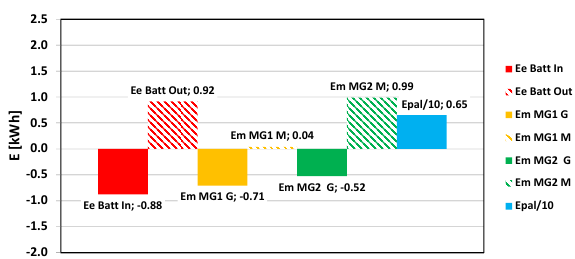
Fig. 3. Energy distribution in the hybrid drive system in the rural part of the RDE test (Toyota Yaris 1.5 Hybrid Dynamic Force e-CVT)